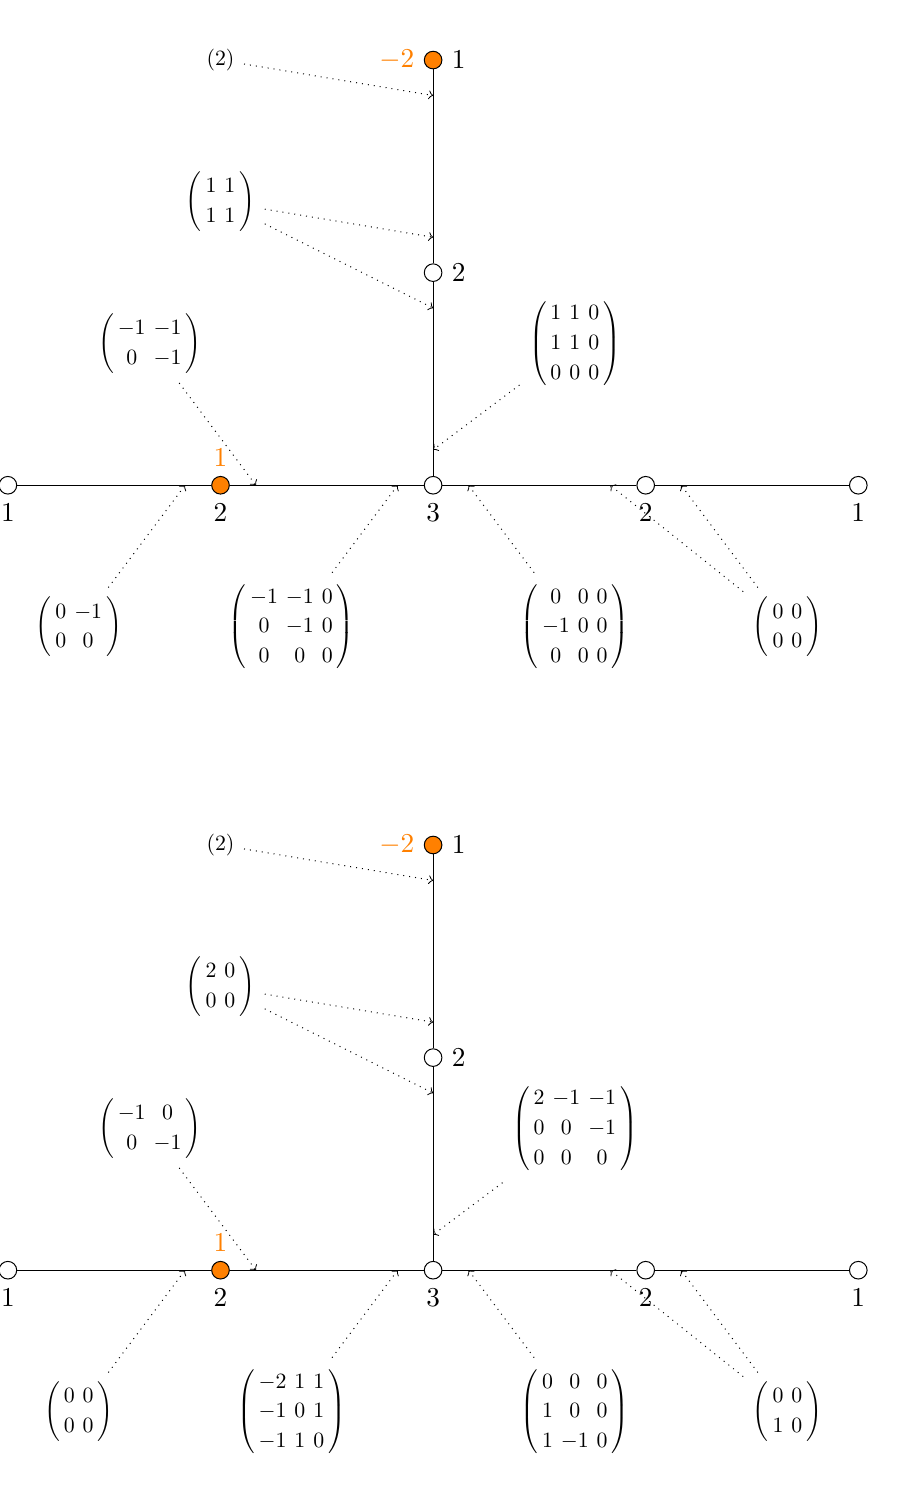
Figure 8 . The two minimal deformations corresponding to the given FI in orange. The top quiver displays Solution 1 in table 1, and the bottom quiver displays Solution